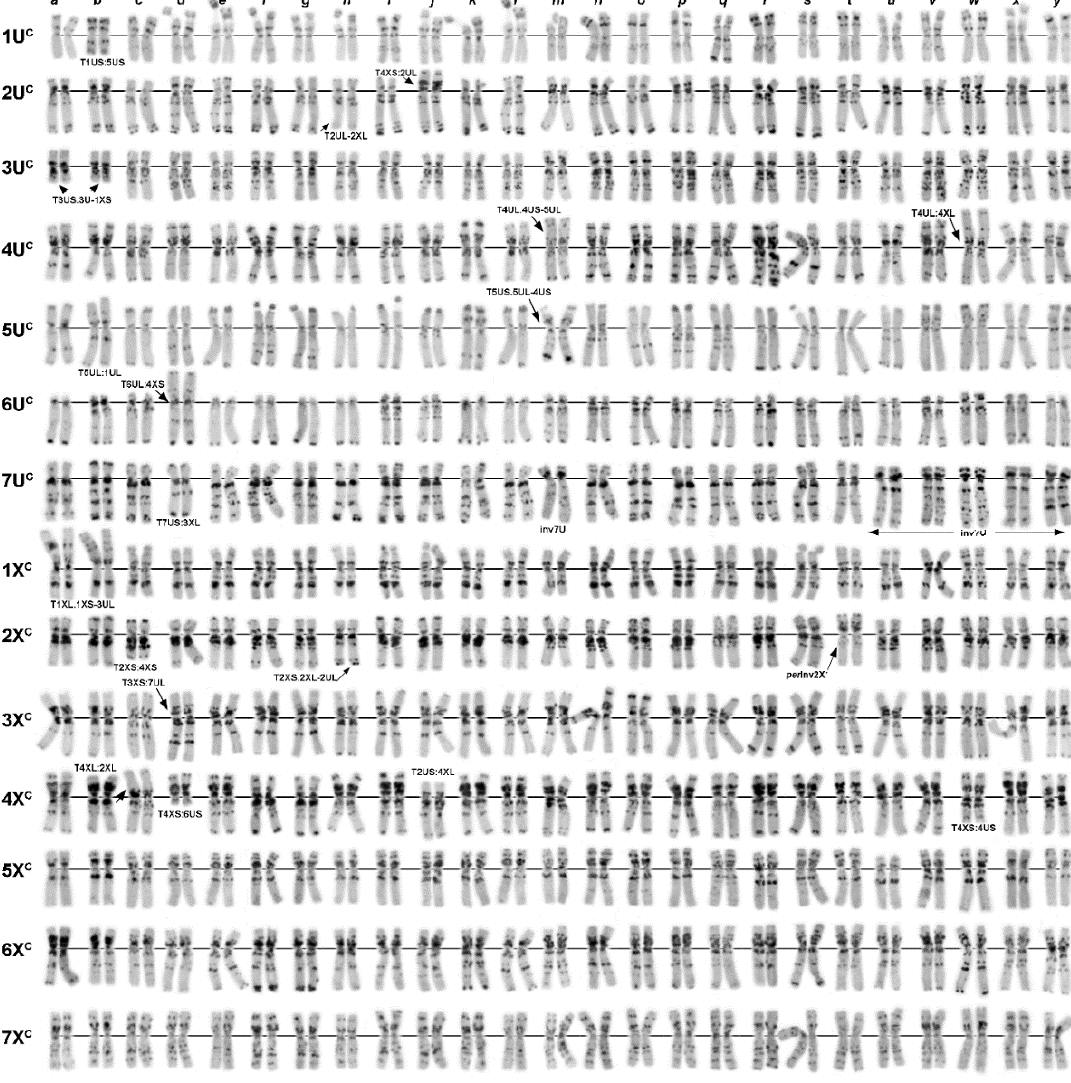
Figure 4. Polymorphisms of the C-banding patterns of Turkish C-I accessions of Ae. columnaris: ( a )—PI 560506; ( b )—K-PI